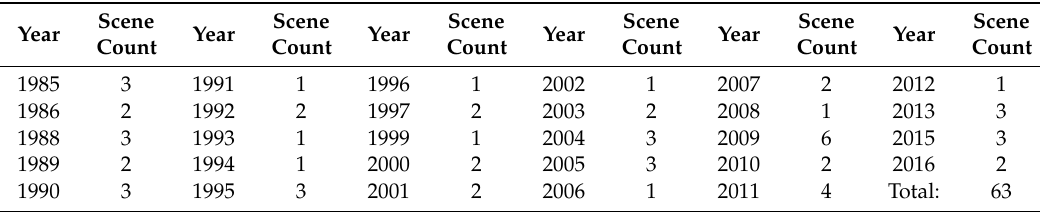
Table 1. Number of Landsat scenes for each year as used in this study (total